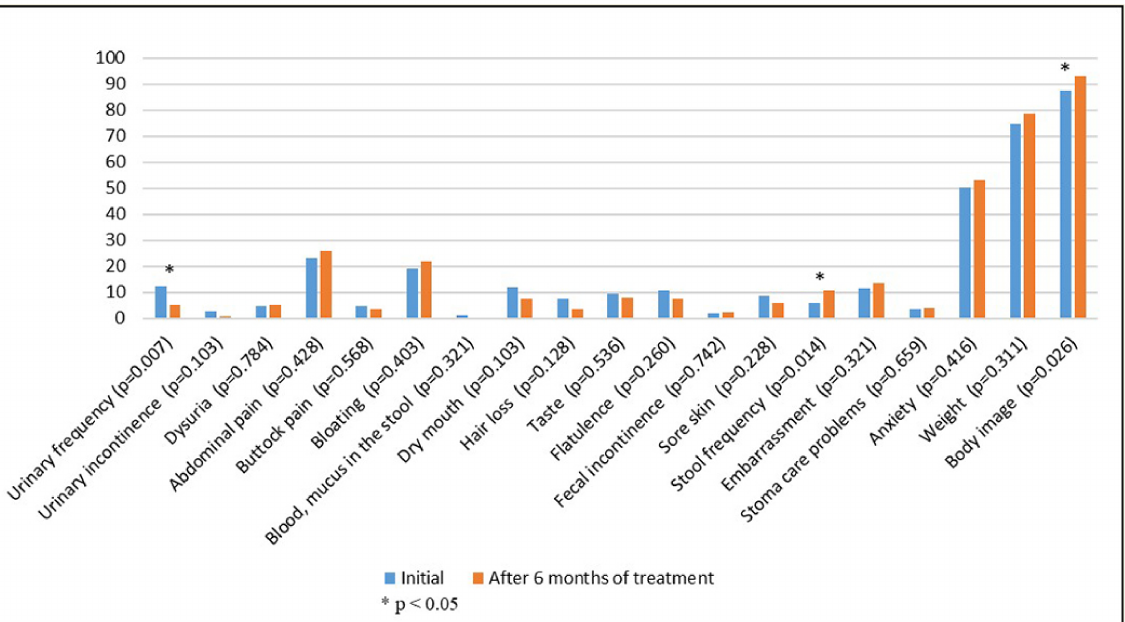
Figure 2. European Organization for Research and Treatment of Cancer QLQ-CR29